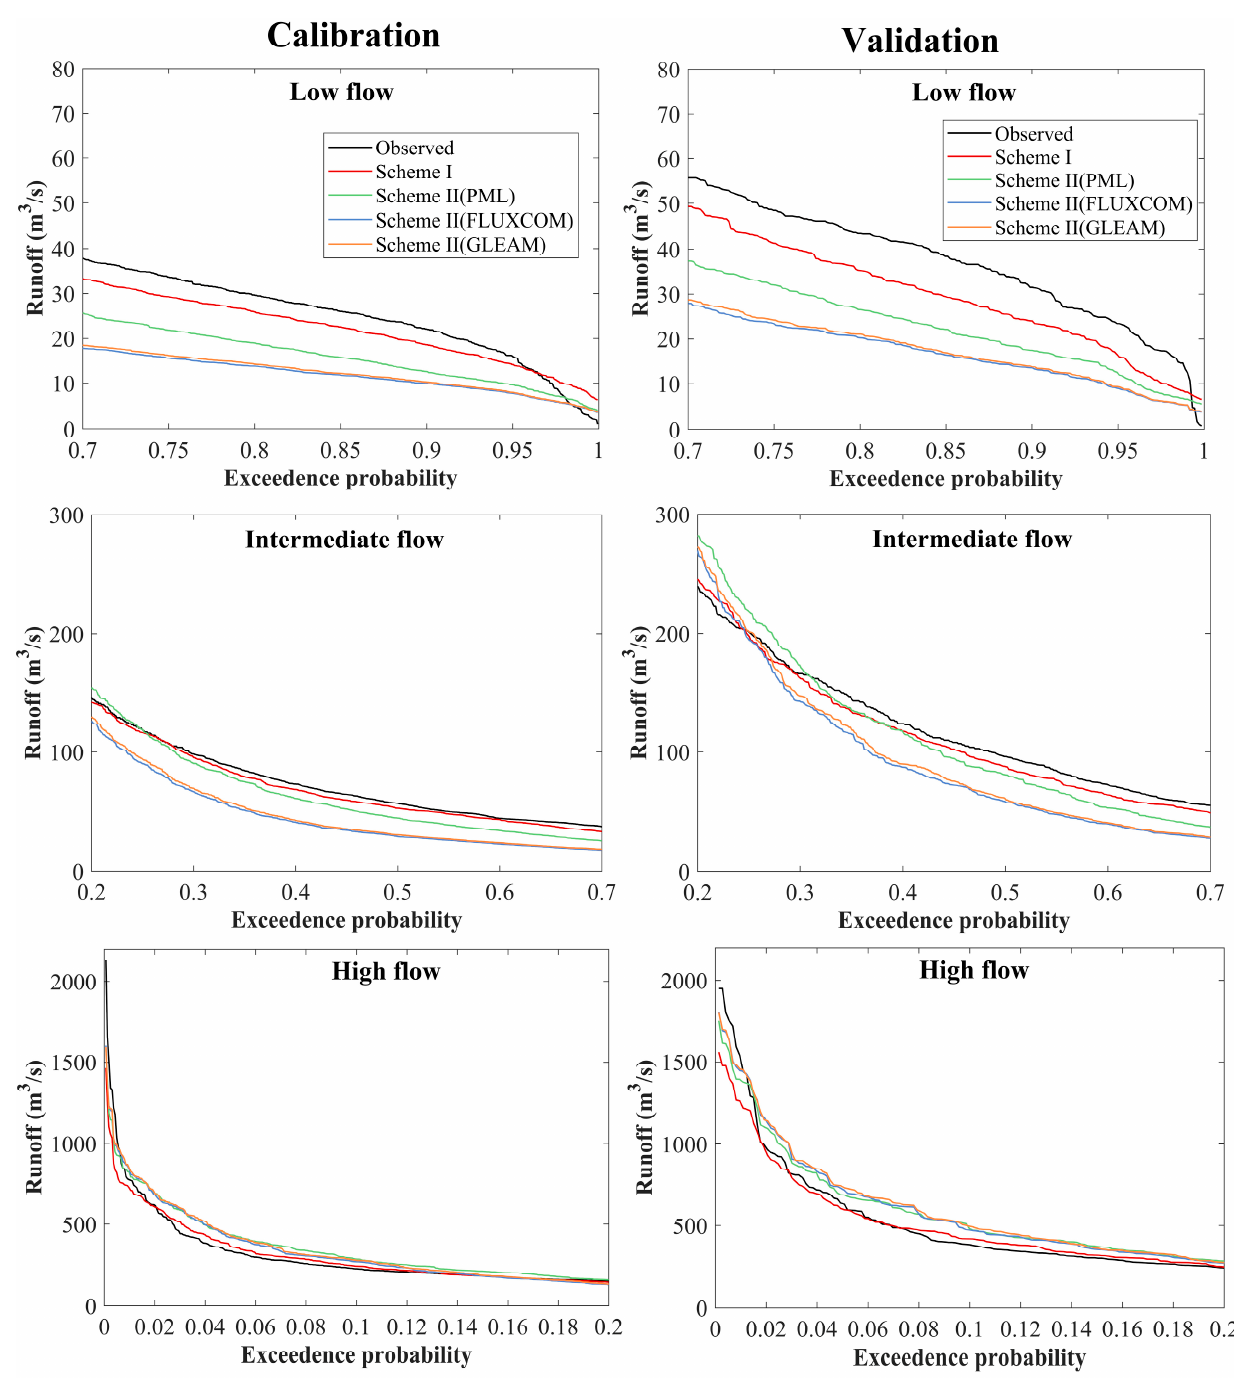
Figure 10. Comparison of three segments of FDC of observed and simulated daily runoff in the calibration and validation periods based on Scheme I and Scheme II. Table 5. The other two hydrological signatures (L1 and H1) in the calibration and validation periods based on Scheme I and Scheme II.